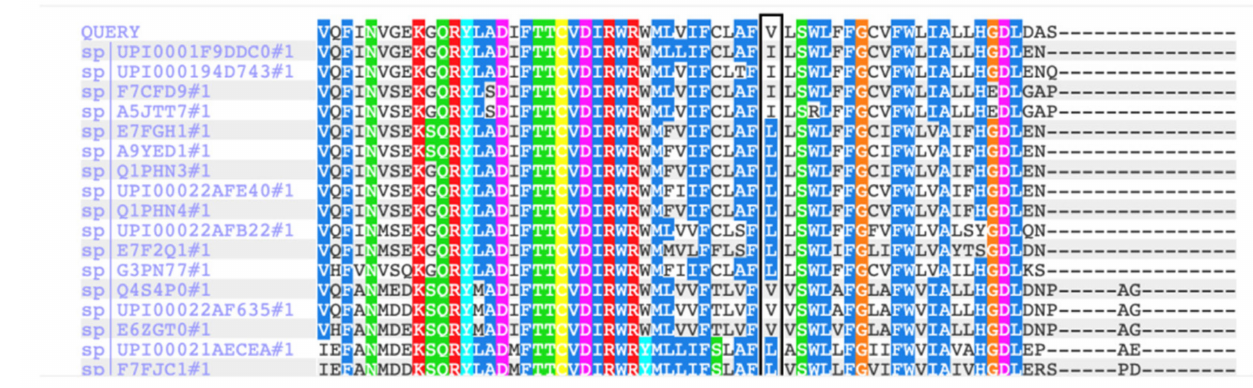
Figure 5. Multiple alignment of the Kir2.1 protein sequencing in different species (by PolyPhen2.0). Position 93 in the Kir2.1 is moderately conserved. Variant Val93 presented in 22 species (79%), variant Ile93—in 6 species